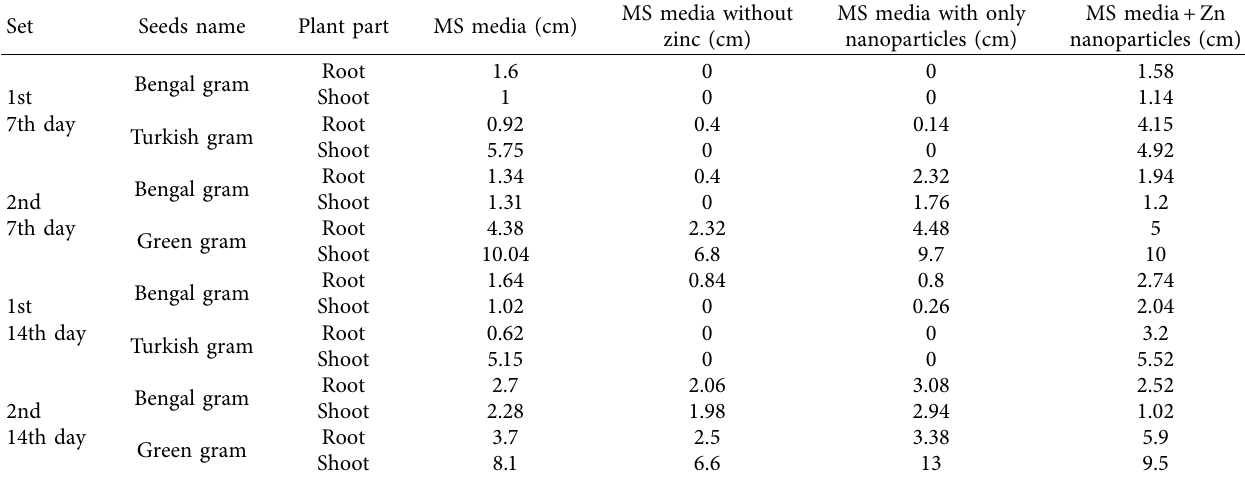
Table 3: Average of root length and shoot length measured in several media.